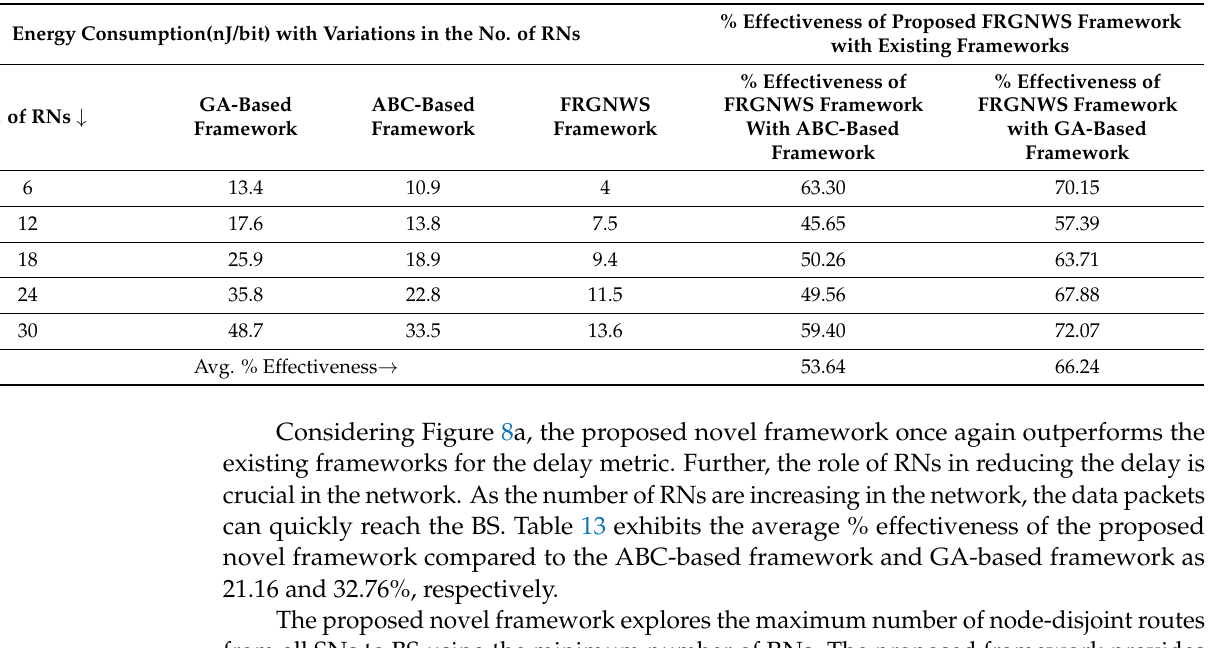
Table 14. The average % effectiveness of the proposed novel framework for the energy consumption metric with variations in the number of